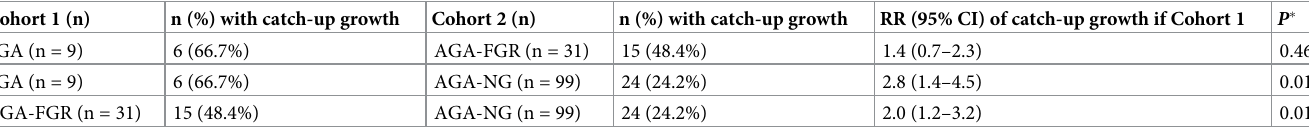
Table 3. Relative risk of catch-up growth in small-for-gestational-age infants compared to appropriate-for-gestational-age infants. Cohort 1 (n) n (%) with catch-up growth